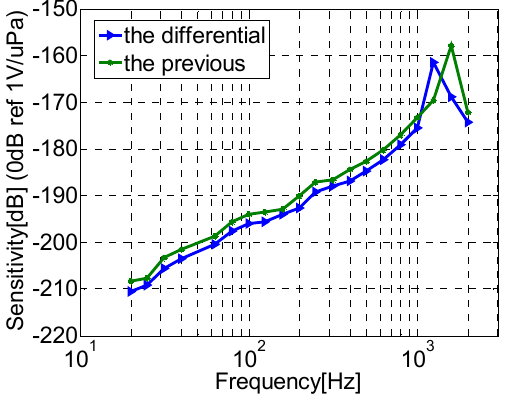
Figure 17. Sensitivity curves of the hydrophones.